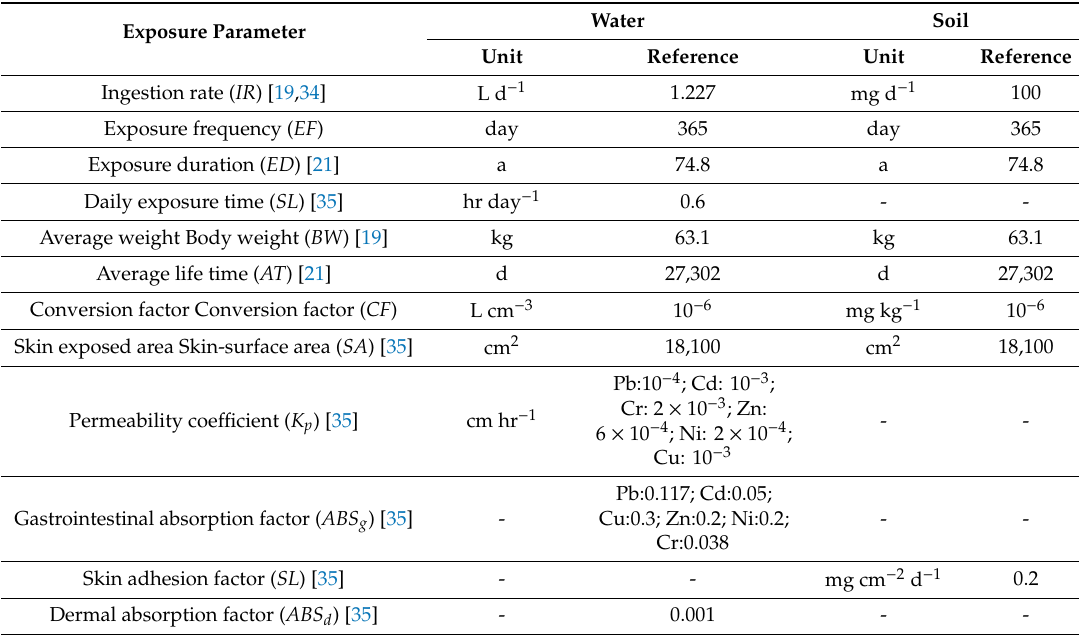
Table 1. Exposure parameters in the health risk